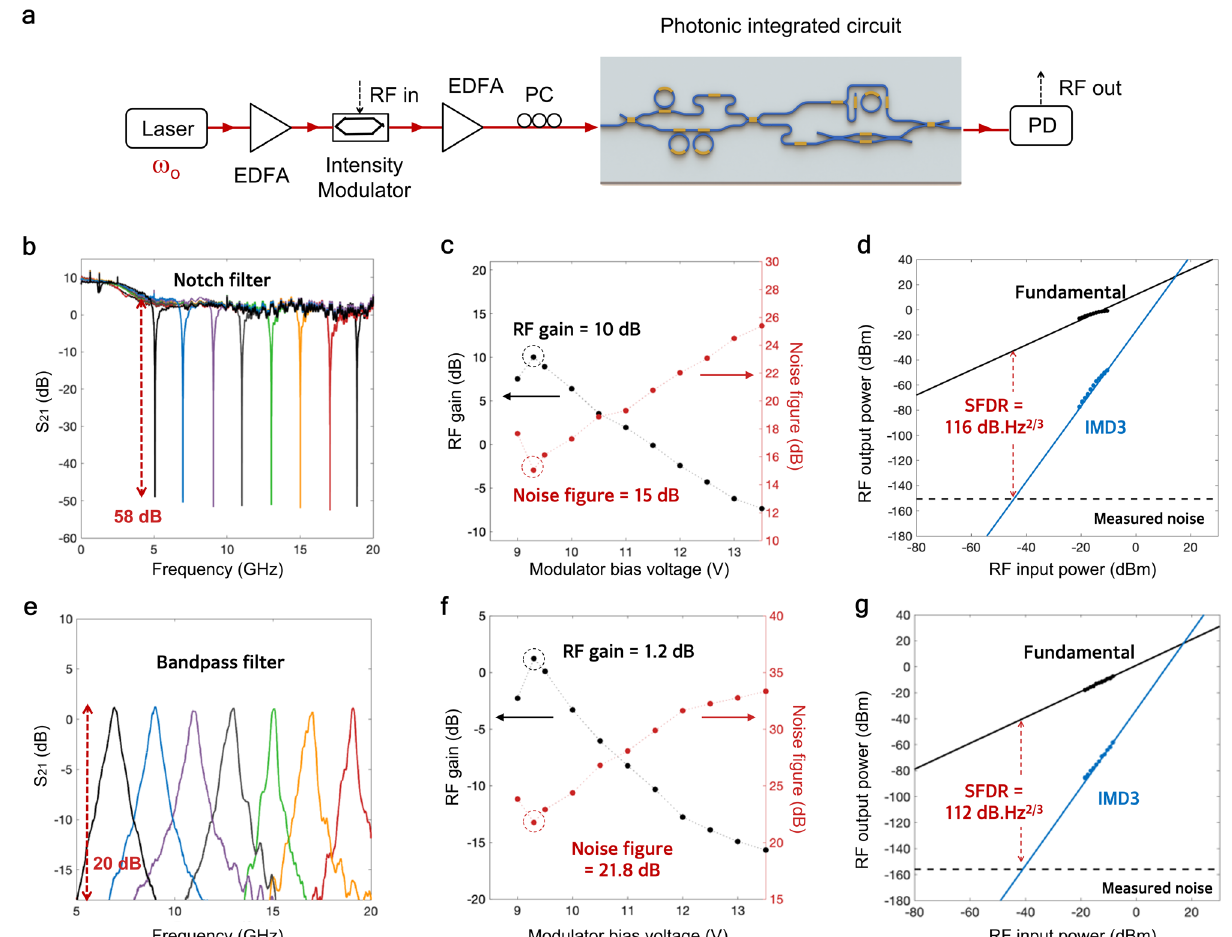
Fig. 3 | Noise fi gure reduction of the programmable MWP fi lters. a Experiment setup of programmable microwave photonics with enhanced performance using low-biasingMach – Zehndermodulator(MZM). b High-rejectionRFnotch fi lterwith 58dBrejection. c ThemeasuredRFgainandnoise fi gure(NF)oftheRFnotch fi lter. Maximum RF gain of 10 dB and a minimum NF of 15 dB are achieved through the low-biasing of the MZM. d The measured spurious-free dynamic range (SFDR) of the RF notch fi lter at 1 GHz, reaching 116 dBHz 2/3 . e Single-sideband (SSB)